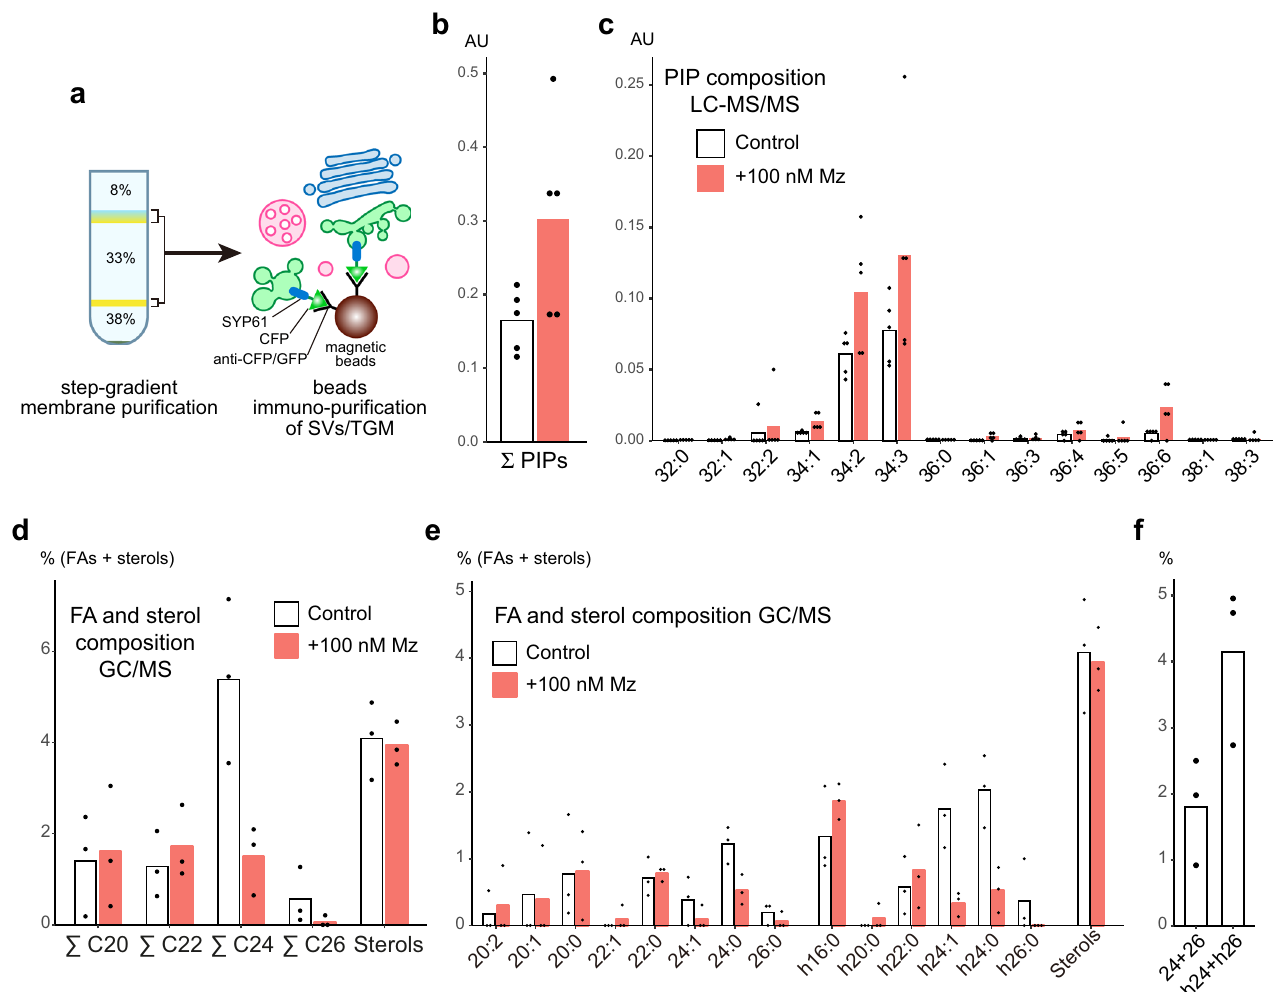
Fig. 3 Composition of phosphoinositol monophosphate and fatty acids at TGN. a Immuno-puri fi cation of intact TGN compartments. Step-gradient- puri fi ed membrane fraction was incubated with magnetic beads conjugated with CFP/GFP antibodies, and the intact compartments labeled by the SVs/ TGN marker SYP61-CFP were immuno-puri fi ed. b, c LC-MS/MS analysis of phosphoinositol monophosphates (PIPs) in immuno-puri fi ed SYP61-SVs/TGN fraction in control condition (white) or treated with 100 nM metazachlor (Mz) (red) ( n = 5 biological replicates, the dots show the dispersion of data, AU Arbitrary Unit (area of peak compound/area of internal standard)). b Mz increases the total amount of PIPs. c Detailed analysis shows that all species of PIPs are increased upon Mz. d , e GC-MS analysis of fatty acid and sterol composition of immuno-puri fi ed SYP61-SVs/TGN fraction in control condition (white) or treated with 100 nM Mz (red) ( n = 3 biological replicates, the dots show the dispersion of data). d While Mz strongly decreased the sum of C24 and the sum of C26 fatty acids it did not affect the sterol content of SVs/TGN. e Detailed analysis shows that both non- α -hydroxylated 24:0, 24:1, 26:0 and α -hydroxylated h24:0, h24:1, h26:0 are reduced at TGN upon Mz. f In untreated control TGN, h24, and h26 (speci fi c of sphingolipids) are